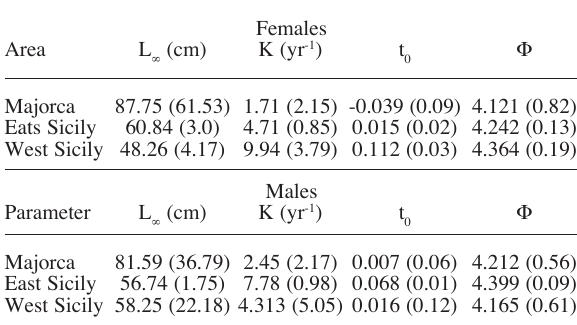
T ABLE 4. – Von Bertalanffy growth parameters determined for each area. The standard error of the estimates is between brackets. Φ : growth performance index (Munro and Pauly,